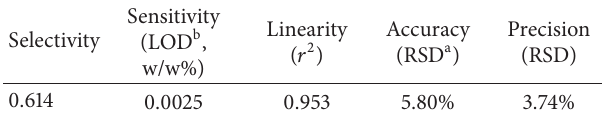
a RSD: relative standard deviation. b LOD: limit of